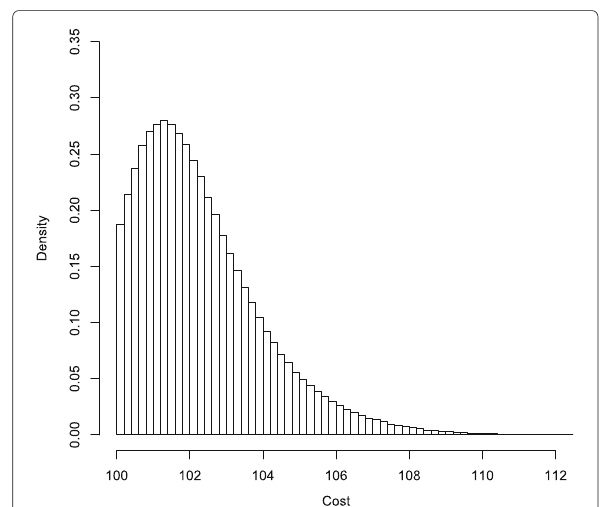
Fig. 3 Histogram for C ( 0,0 ) . This figure is a histogram for the procurement cost C ( 0,0 )